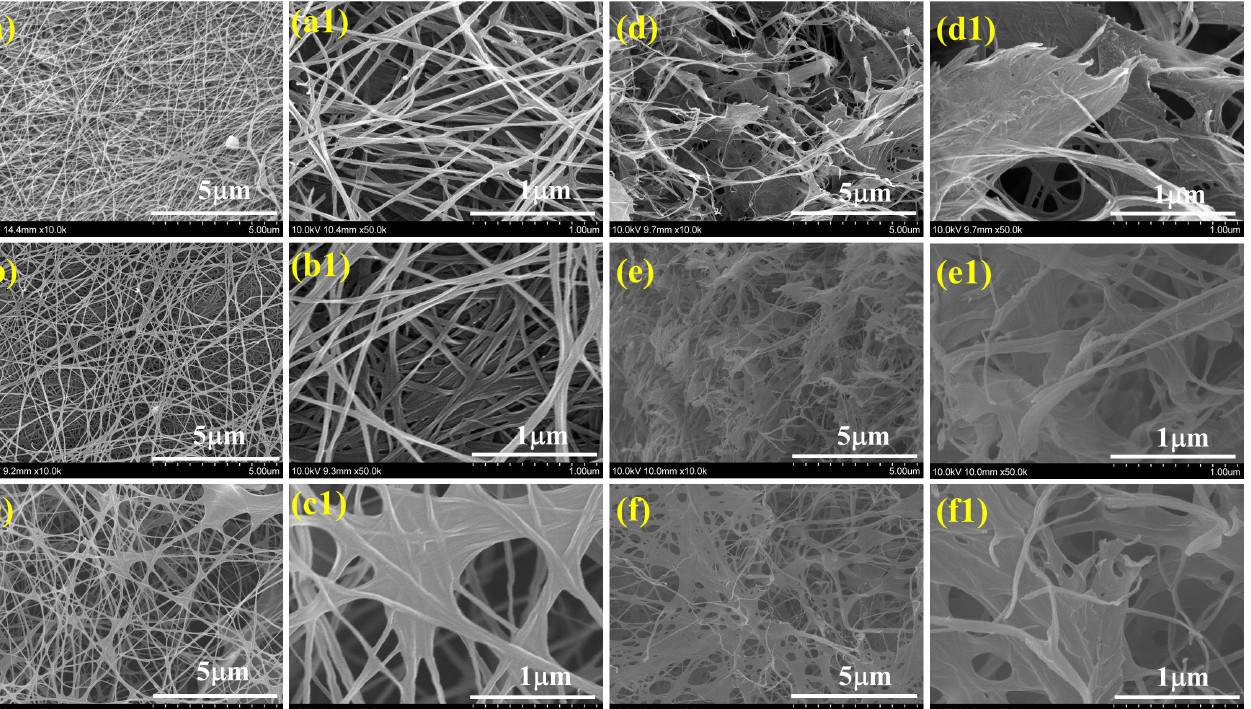
Figure 3 displayed the morphology of freeze-dried pure BC and CMCS–BC hydrogels were acquired using SEM. The SEM images of BC showed the nanoporous structure of a three-dimensional network with the random assembly of ribbon-shaped fibers (a and a-1) [24]. The CMCS–BC hydrogels represent the fibrous network structures, representing the CMCS polymer chains that are well-connected to BC fibers. The increasing amount of CMCS in the BC fiber networks increases the CMCS polymer chains well-connected with BC fiber due to the CMCS having a hydrophilic group and increasing hydrophilic character of cellulose fibers in the CMCS–BC hydrogels [25]. These fibrous and interconnecting porous structures allow for cell recruitment to aid in the penetration of nutrients and oxygen for wound-dressing purposes.